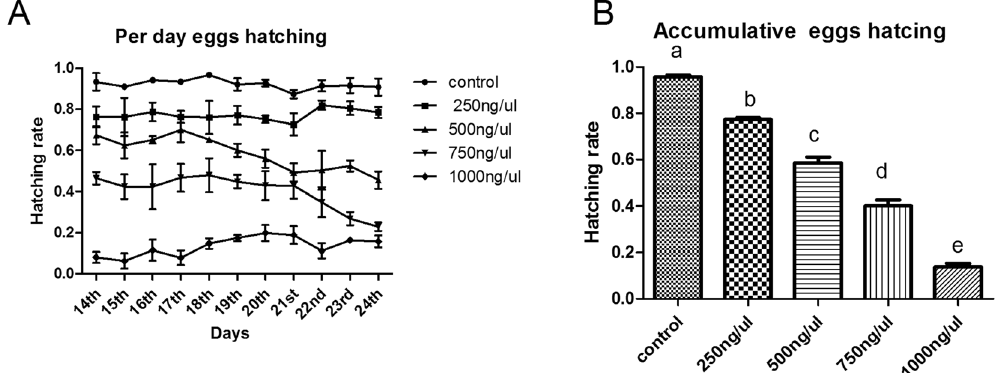
Figure 6. Egg hatching rate in response to different concentrations of dsRNA for the boul + zpg genes. ( A ) The average number of eggs hatched per day between target gene dsRNA and ds-EGFP at different concentrations. ( B ) One way ANOVA indicates a difference in the accumulative number of eggs hatched at different concentrations compared with the control group. Different letters indicate the significant differences between all treatments. Three biological replicates were performed (P < 0.0001, Tukey test).